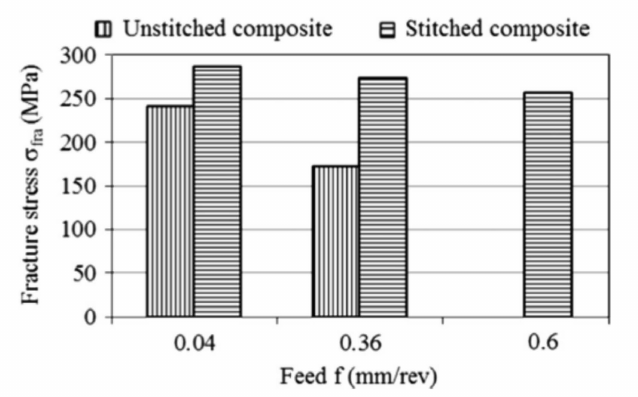
Figure 23. E ff ect of drilling feed rate on the open-hole tension (OHT) strength of unstitched and stitched composites